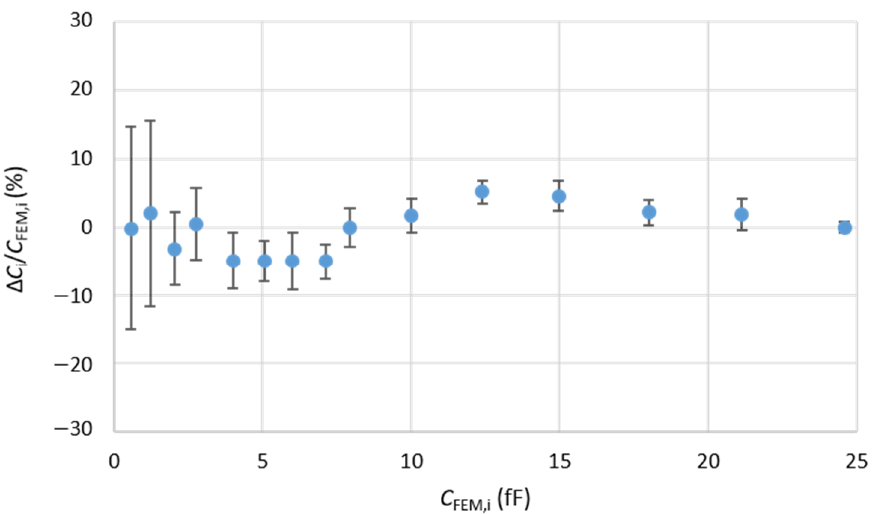
Figure 11. Relative differences ∆ C i / C FEM,i (in%) between measured C exp,i and FEM calculated C FEM,i capacitance values for 15 capacitors Ci of the PZT sample at 3.67 GHz. The SMM has been calibrated using the three capacitors of calculated capacitances 0.56, 7.93, and 24.69 fF.